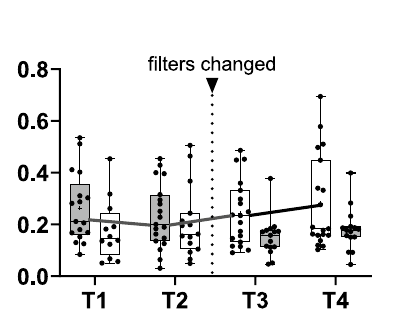
Figure 4. ( A – C ) Report mean and 95% CI intervals for leukocytes, lymphocytes and CD3+ cells as reported above stratified by timepoint and treatment (MCO vs. high flux dialysis). P values were obtained from linear mixed effect models with subject ID (nested in sequence) with treatment (MCO = 1), period and sequence as main effects. A P values of < 0.05 was considered statistically significant. For CD3+ cells as well as ( B ) and ( C ) flow cytometric analysis was performed on re-thawed cryopreserved PBMCs which had been collected before the dialysis session (0 h) at all four study visits. Cells were then either left untreated ( B ) or stimulated with PMA + Ionomycin ( C )—viability was generally > 85%. Means and SD can be obtained from Table 4. For details with regards to the gating strategy see